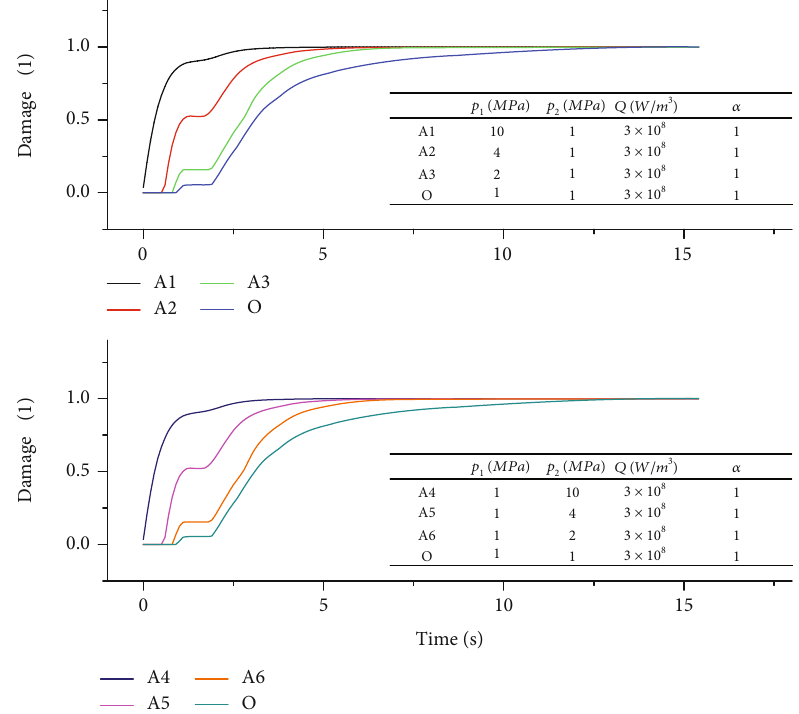
Figure 6: Maximum damage evolution curves under di ff erent unilateral